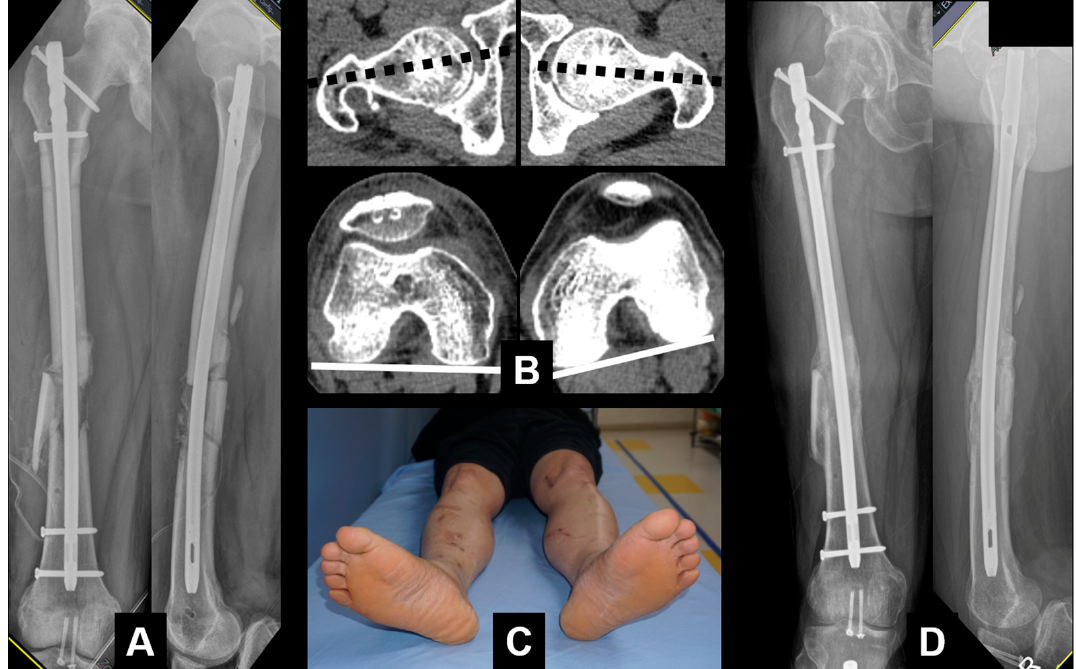
Figure 3. ( A ) Postoperative radiographs showing antegrade nailing with bone graft at the nonunion site; ( B ) CT scan showing similar angles of anteversion; ( C ) similar rotation in foot position; ( D ) complete healing observed 1 year postoperatively.